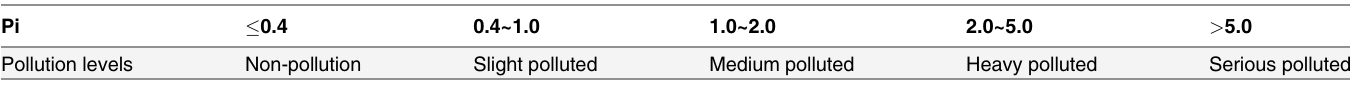
Table 2. Standard of single factor pollution index.